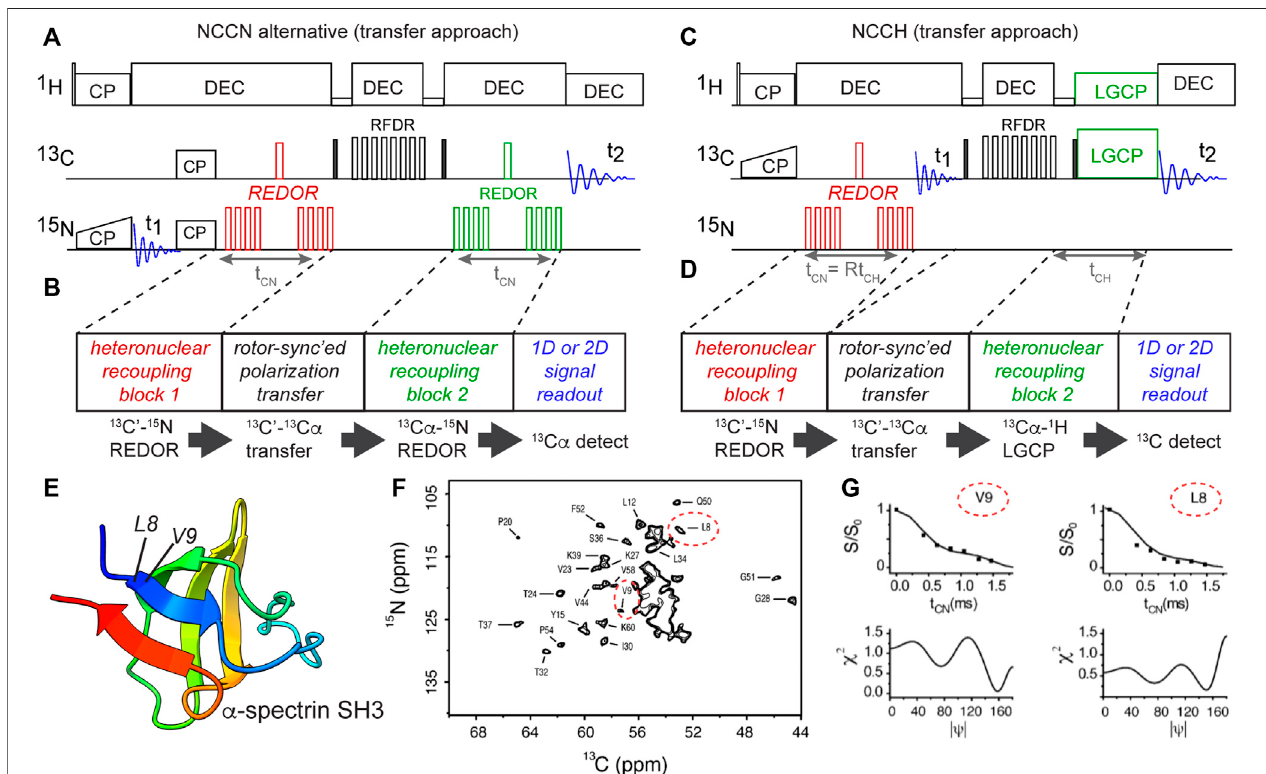
FIGURE6| Transfer-based torsionanglemeasurementsofbackboneangle ψ . (A,B) NCCNpulsesequenceimplemented without 13 CDQgeneration,usingrotor- synchronized 13 C- 13 C transfer instead (Ladizhansky et al., 2003). Carbonyl (C ′ ) polarization is created via a double CP scheme, followed by REDOR-based 13 C- 15 N recoupling(timet CN ).Theresidual 13 C ′ signalistransferred toneighboring 13 C α viaashortRFDRblock,afterwhichthe 13 C α - 15 Nrecouplingisdone(alsofort CN ).Finally, theremaining 13 Csignal(asafunctionoft CN )isrecordedinaseriesof1Dor2DN(CO)CAspectra(seepanelF). (C,D) NCCH-typemeasurementsofthe ϕ backbone anglebased on the same design principle (Ladizhansky et al., 2002). Here, 13 C- 1 H dipolar recoupling occurred during the LGCP period. Note that here the REDOR time (t CN ) and LGCP time (t CH ) are both incremented in parallel. Panels B and D illustrate the generic design of these experiments, with color-coding of the dipolar recoupling blocks. (E) Structure of α -spectrin SH3, with residues L8 and V9 in the fi rst β -strand marked (Musacchio et al., 1992), prepared with UCSF ChimeraX (Pettersen et al., 2021). (F) 2D N(CO)CA spectrum for uniformly labeled α -spectrin SH3, showing peaks for 13 C α i - 15 N i+1 correlations between residues i and i+1. Peaks for the C α of residues L8 and V9 are indicated with red ovals. (G) Example N(CO)CA NCCN data curves for L8 and V9, along with matching values of the ψ angle. Panels (F-G)